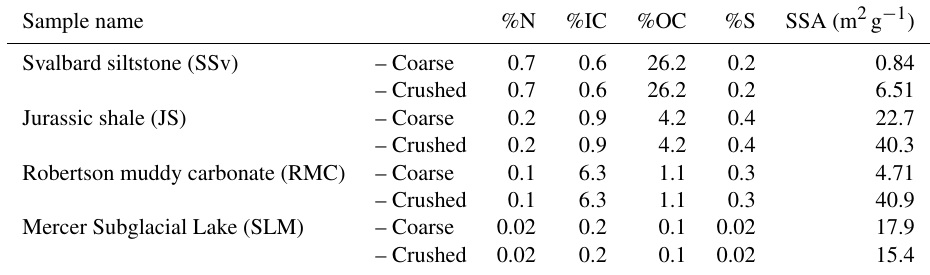
Table 1. Total concentration of N, inorganic carbon (IC), organic carbon (OC) and S, as determined by elemental analysis, and specific surface area (SSA) of sedimentary rock and subglacial sediment samples. “Coarse” samples were broken up to 125µm to 2mm in size using a mallet and plate (JS and RMC) or a pestle and mortar (SSv and SLM). “Crushed” samples were subsampled from “coarse fractions” and ground using a planetary ball mill (500rpm for